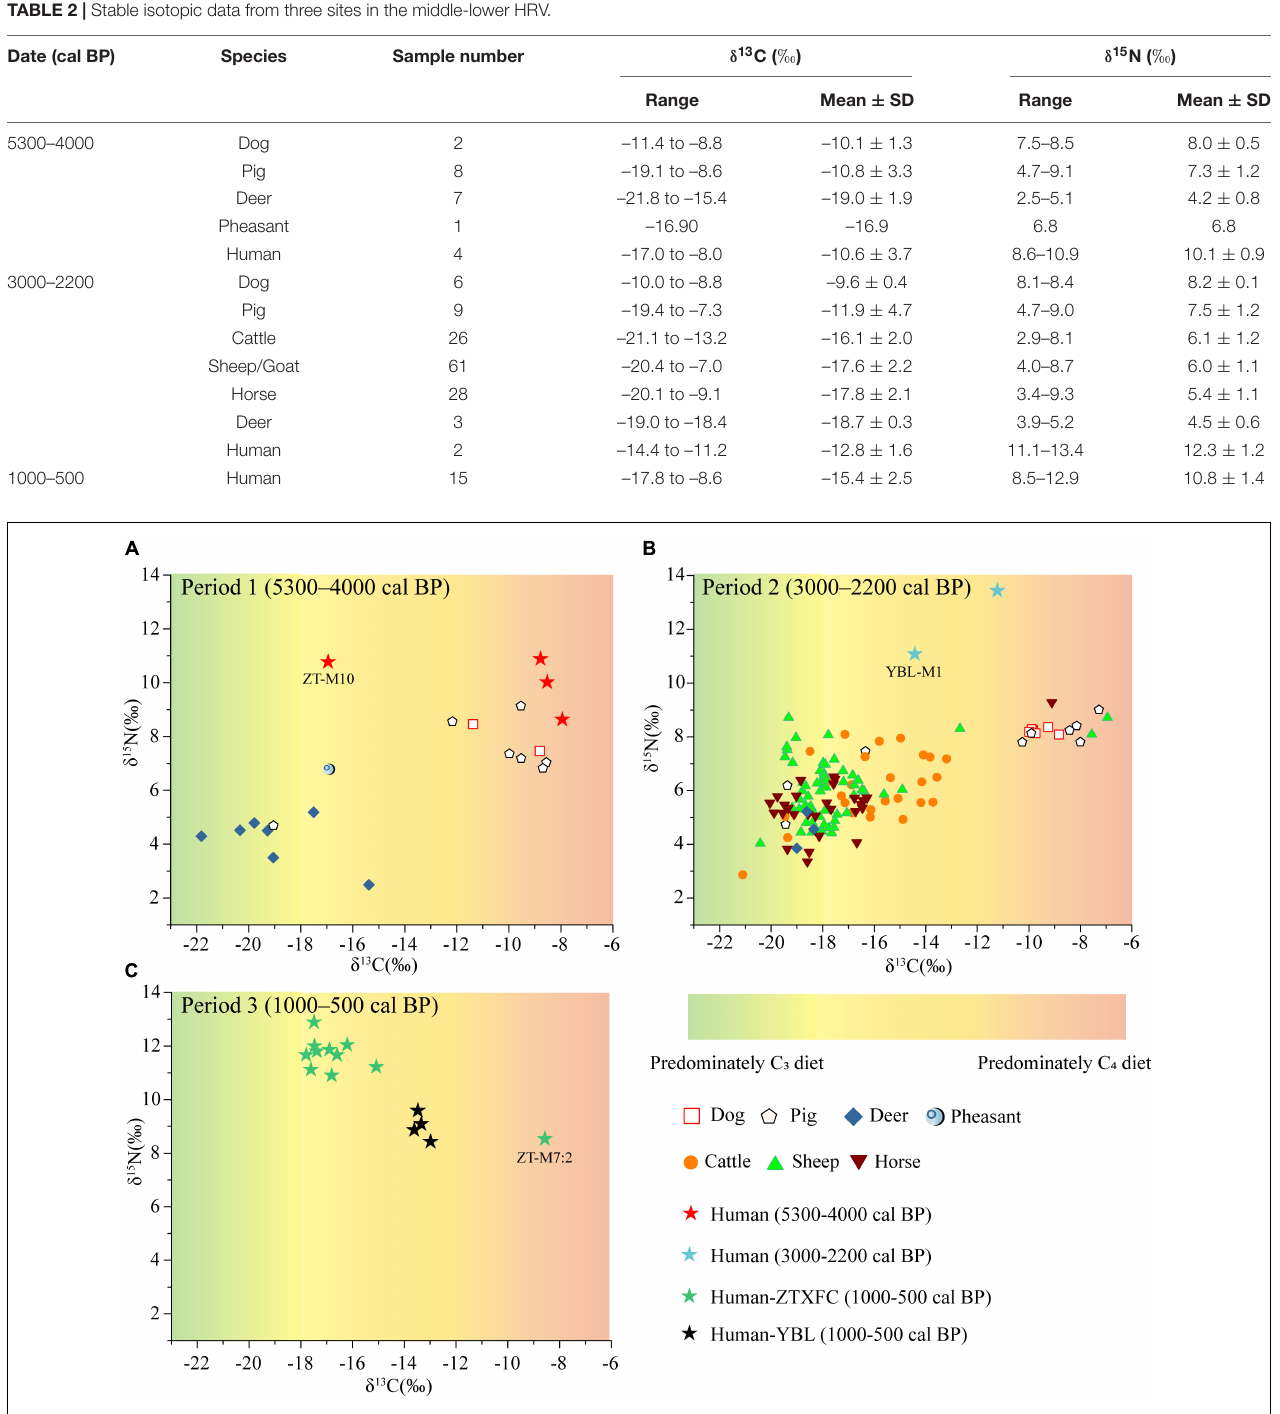
FIGURE 2 | Carbon and nitrogen isotopic results for humans and animals from sites in the middle and lower reaches of the Hulu River Valley during (A) Period 1 (5300–4000 cal BP); (B) Period 2 (3000–2200 cal BP) and (C) Period 3 (1000–500 cal BP).